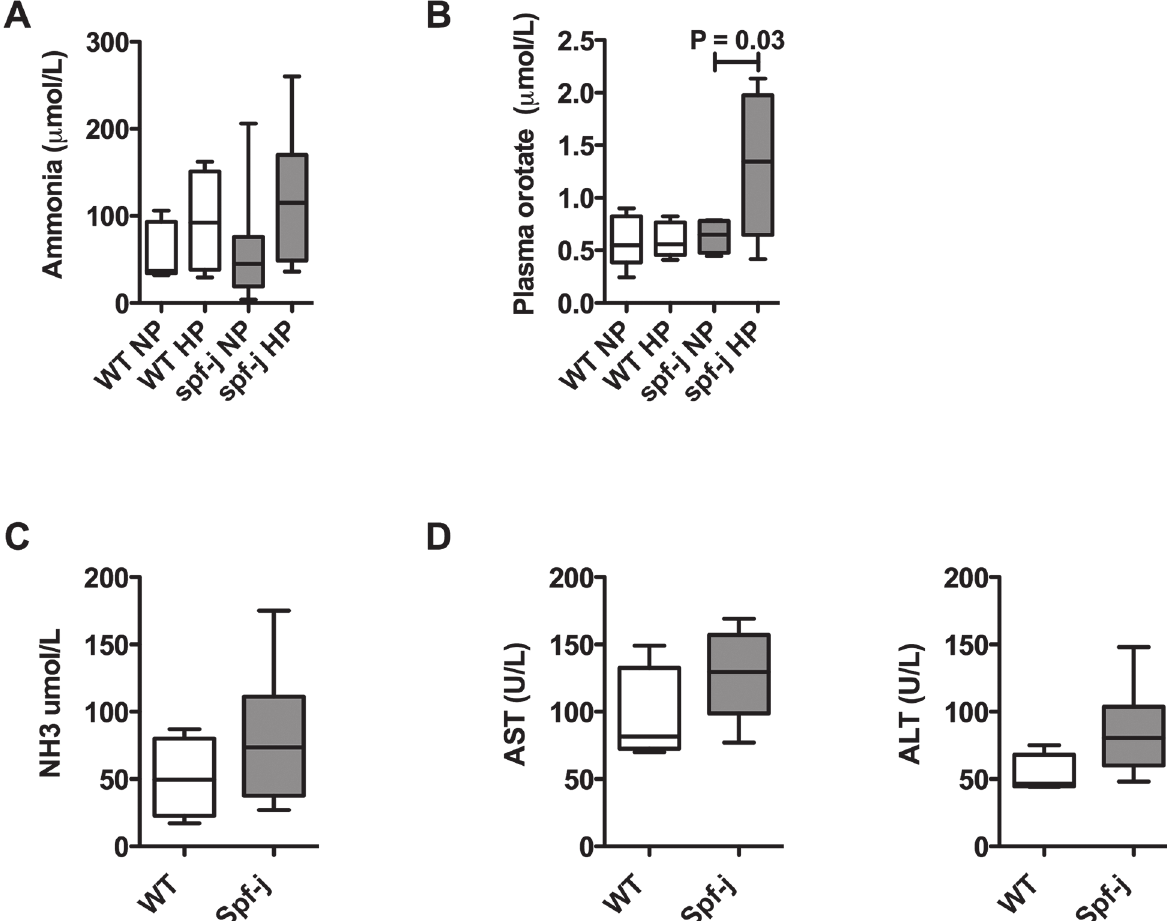
Figure 4. Urea cycle perturbations in Spf-J males. Spf-J (8 weeks) were maintained on a high protein chow diet (70% protein) and euthanized after 2 weeks (N = 6 / group). Blood was collected by retro-orbital bleeding with plasma separated and stored at − 80°C until use. WT – wild-type, NP – normal protein, HP – high protein. A) Plasma ammonia and B) Plasma orotate for spf-j and WT. For immune challenge, 8-week-old spf-J (N = 6) and WT (N = 4) received an intraperitoneal injection of poly I:C (100 μ g) once a day for 3 days. Tissues harvested and snap frozen and stored at − 80°C until use. C) Plasma ammonia. D) Liver transaminases. Hatched bar indicates P < 0.05. WT –